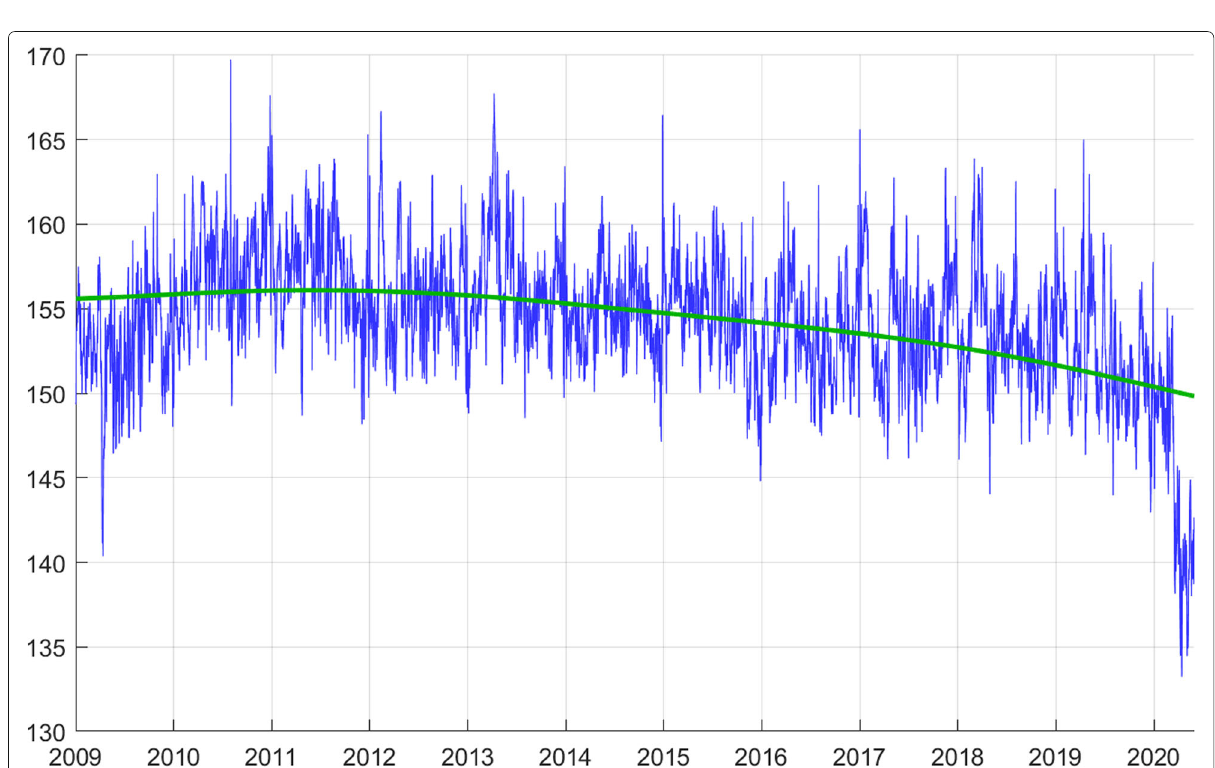
Fig. 3 Daily data adjusted for weather, calendar effects, and seasonality ( Z ), together with the trend ( Y ∗